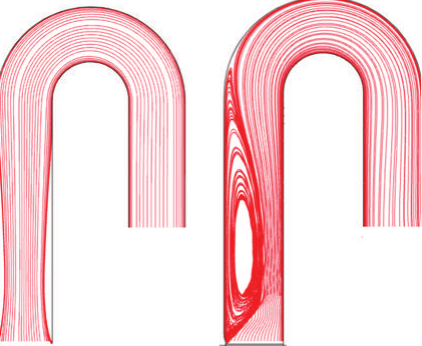
Figure 12: Flows paths at mass flow 0.175 kg/s, first-order upwind and second-order central discretization.